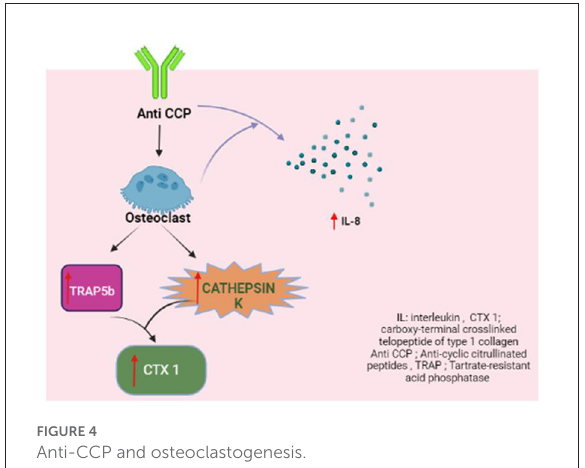
FIGURE4 Anti-CCP and